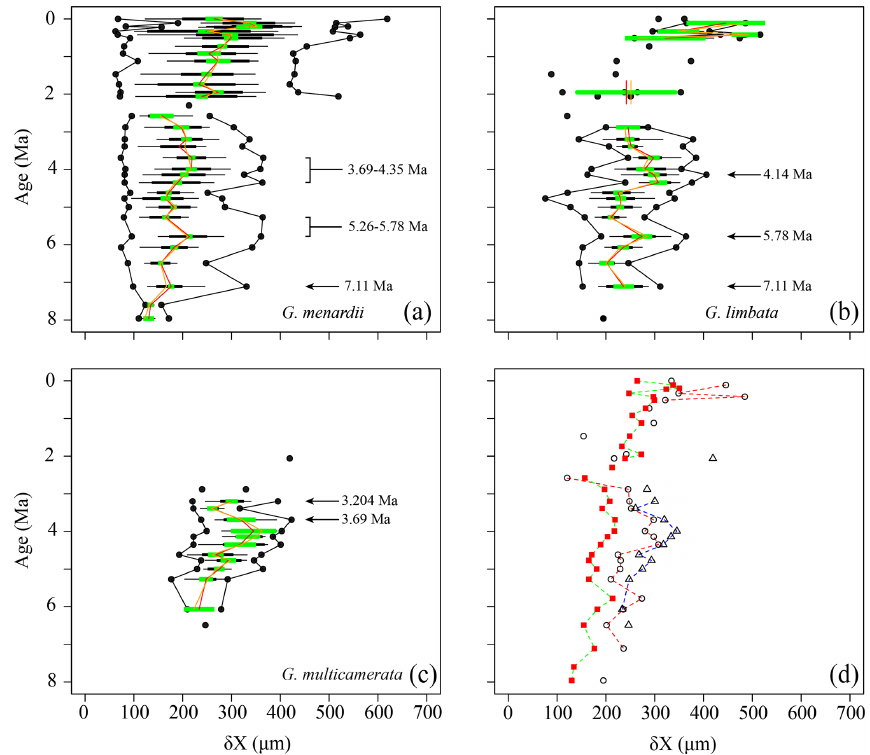
Figure 5. Spiral height ( δX ) in keel view (in µm) versus time (Ma) at ODP Hole 667A for (a) G. menardii , (b) G. limbata , (c) G. multicam- erata and (d) the mean values of the three species. In (a) – (c) , black dots represent minimum and maximum values. The thin horizontal black bars represent the 10% to 90% sample percentiles and thick black bar bars the lower and the upper quartiles, and the green horizontal bar shows the confidence interval of the mean. Means are illustrated as a vertical red line and median values by an vertical orange line. In (d) , δX means of G. menardii are shown as red squares, those of G. limbata by black circles and means of G. multicamerata by black triangles. Samples containing fewer than three specimens of the corresponding species are shown as isolated symbols because this number does not allow reasonable statistical